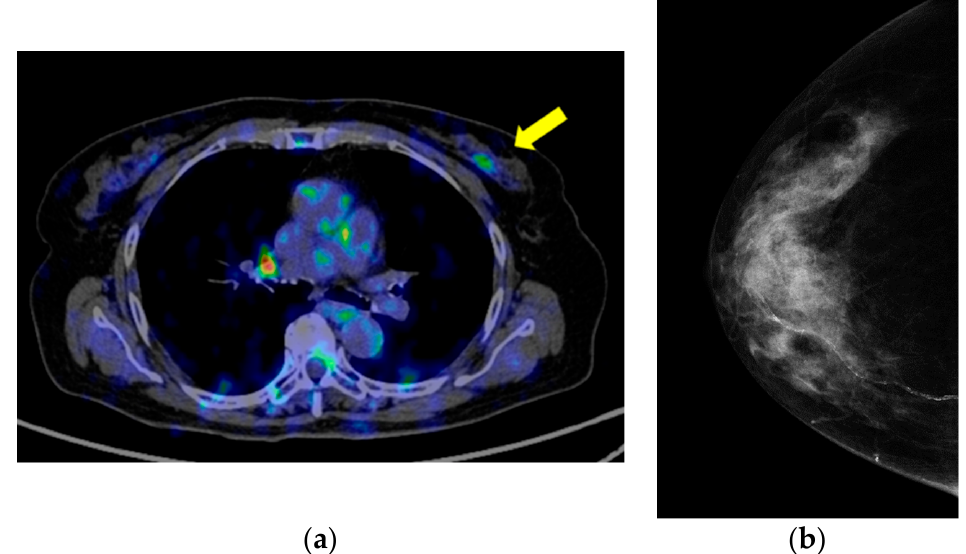
Figure 4. ( a ) Positron emission tomography showing the accumulation of fluorodeoxyglucose in a 2 cm mass lesion in the A region of the left breast; ( b ) mammography showing the U region of the MLO and the I region of the craniocaudal, indicating construction disorder.